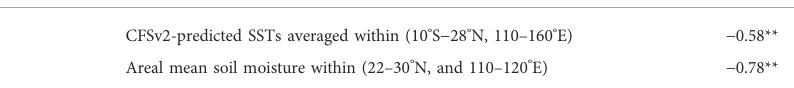
TABLE 1 De fi nitions of the predictors and the correlation coef fi cients between PC1_obs and the predictors.